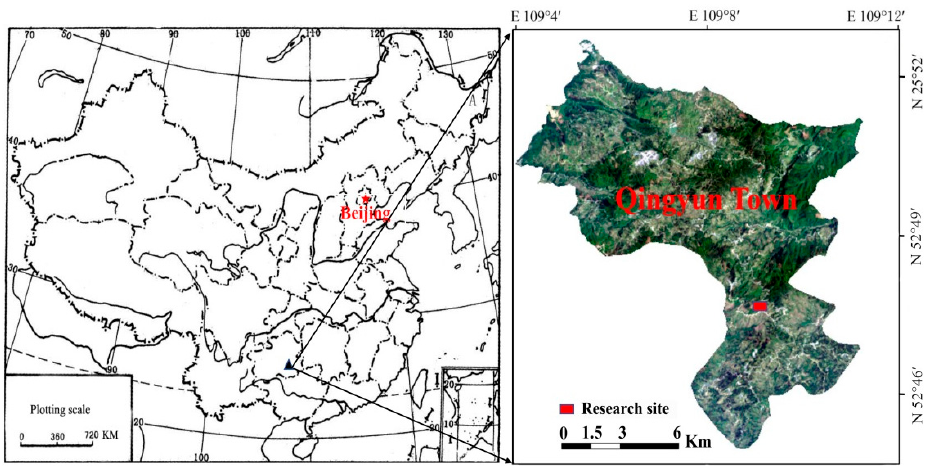
Figure 1. Satellite image of Qingyun Town, Congjiang County, Guizhou Province.